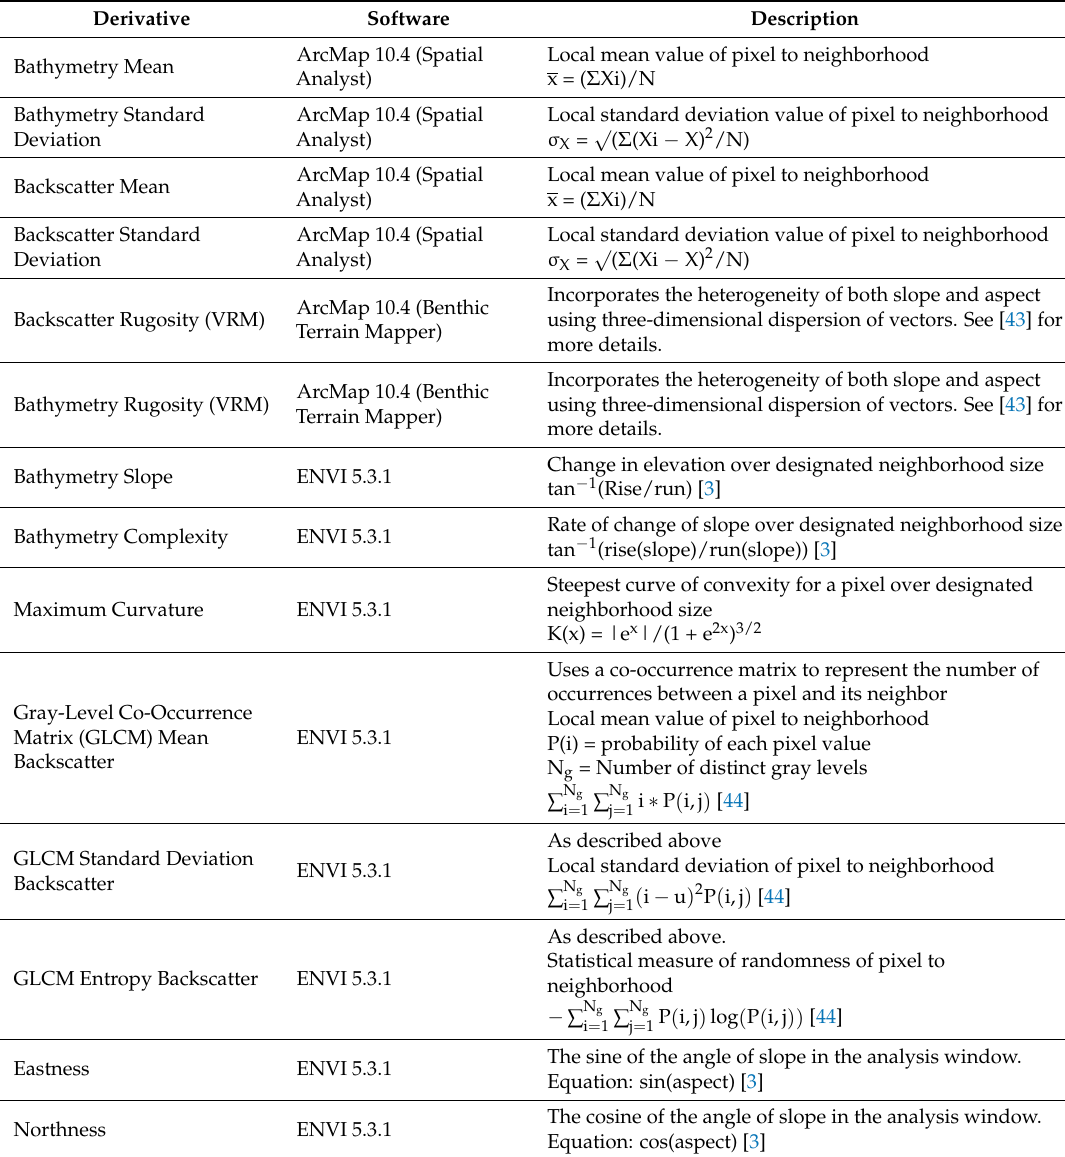
Table 1. List of variables and their respective equations. See Figure 2 for examples of derivative